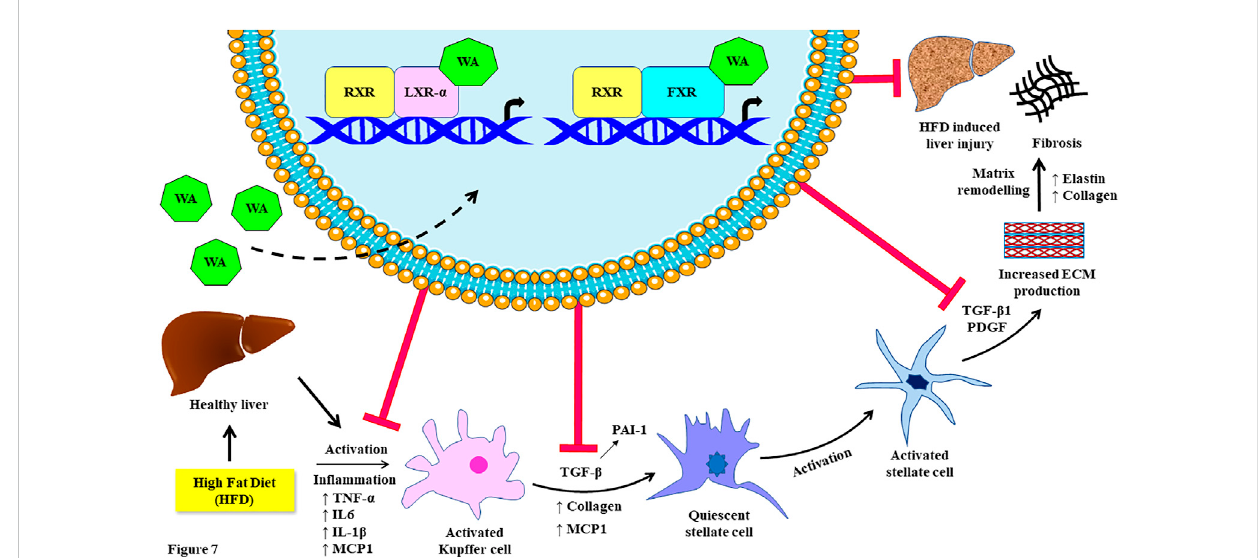
FIGURE 7 SchematicrepresentationoftheinhibitingeffectofwithaferinAonhigh-fatdiet(Westerndietsugarwater)-induced fi brosisbyactingasanLXR/FXR dual receptor activator. This fi gure was created in part using Servier Medical Art, which is licensed under a Creative Commons Attribution 3.0 Unported